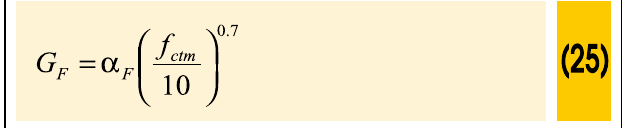
: coefficient that depends on the maximum aggregate size as F given in table 2. The fracture energy, G , can be calculated as: F